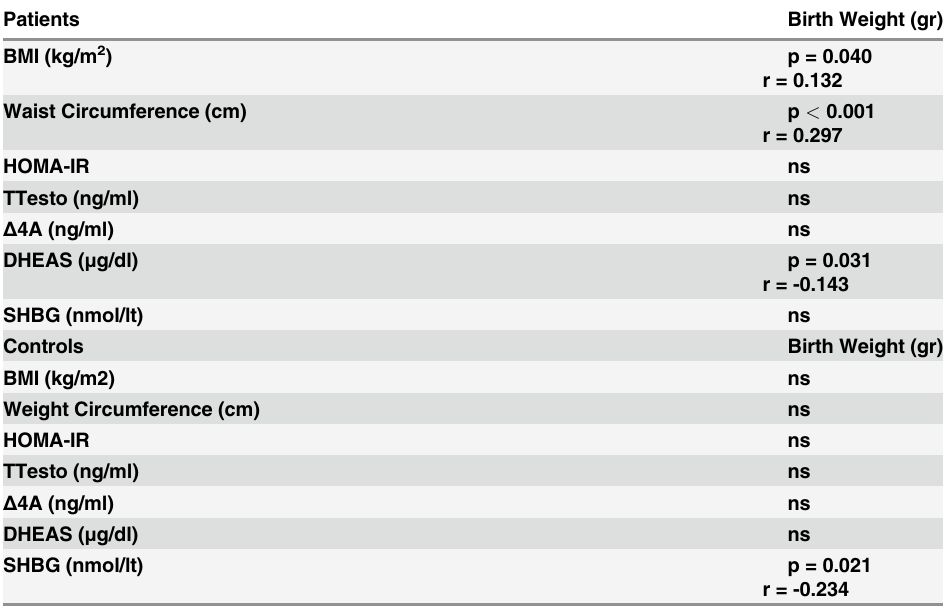
Table 2. Correlations of birth weight with important clinical and biochemical parameters of